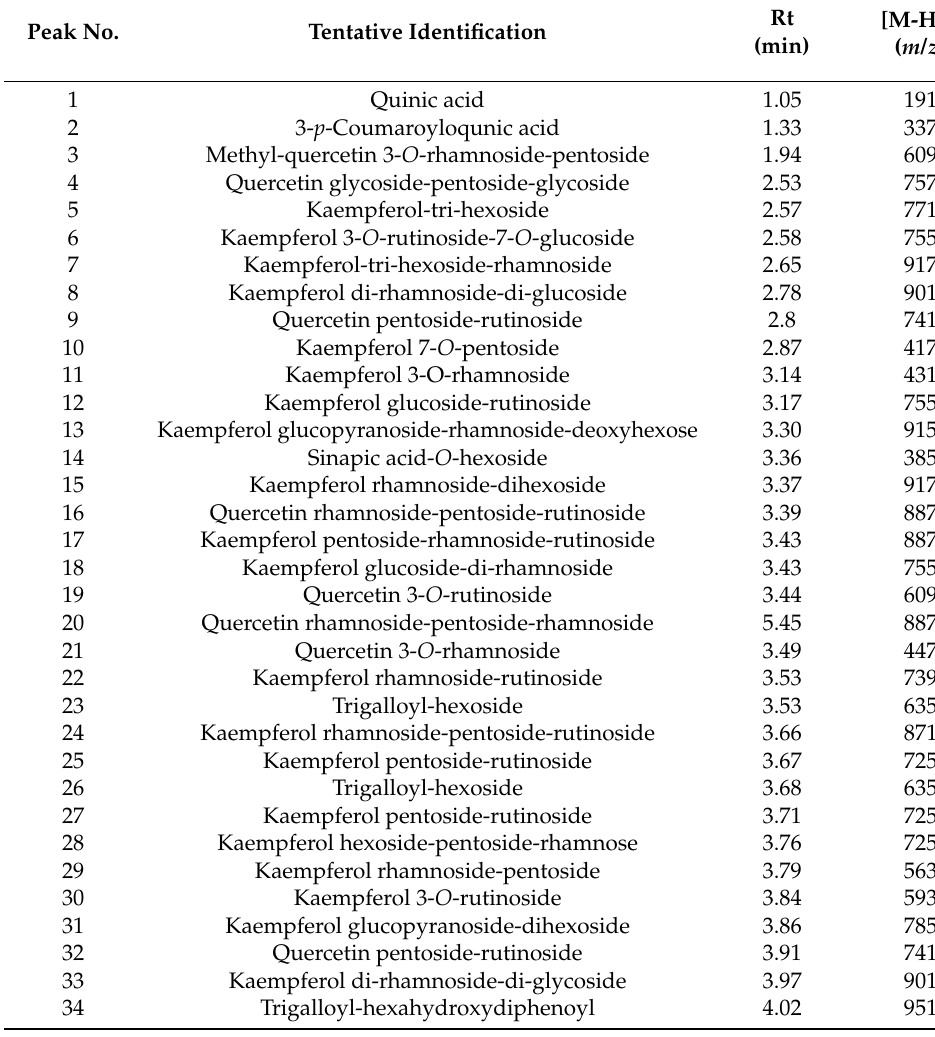
Table 1. Tentative identification of polyphenolic compounds in the seeds, fruit skin + pulp, and leaves of cherry silverberry. Peak